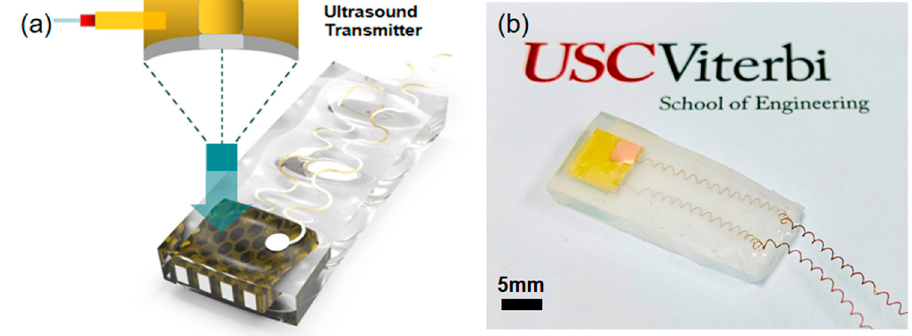
Figure 7. ( a ) Schematic and design of the ultrasonic device. ( b ) Optical image of the fabricated device.